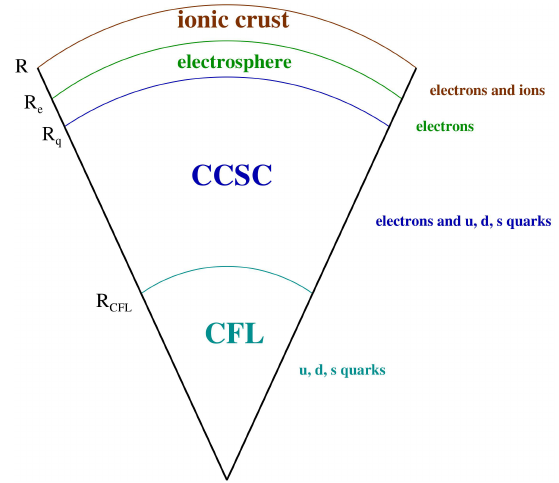
Figure 1. Schematic picture (not in scale) of the stellar model we propose. The mass of the structure is around 1.4 M (cid:12) , and the total radius is R (cid:39) 9.2 km. The electrosphere has a thickness of few hundred fm, while the ionic crust has a thickness of about 200 m